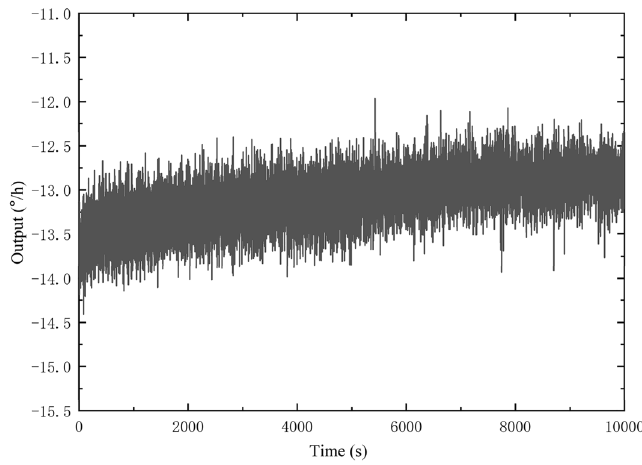
Figure 6. Gyro output